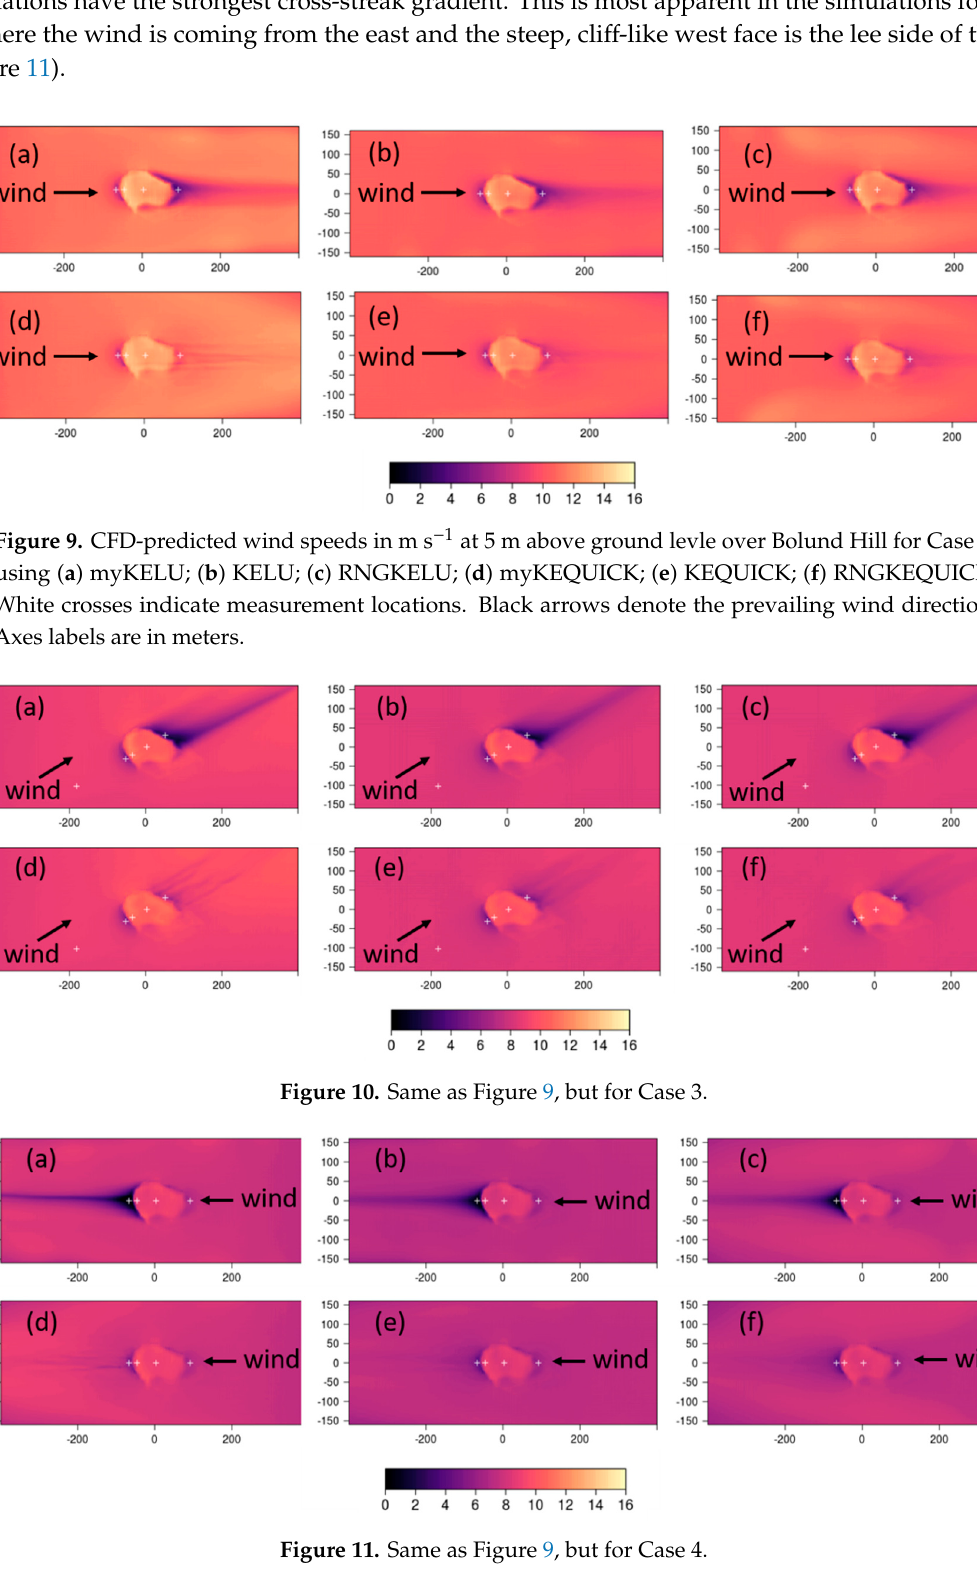
Figure 11. Same as Figure 9, but for Case 4.